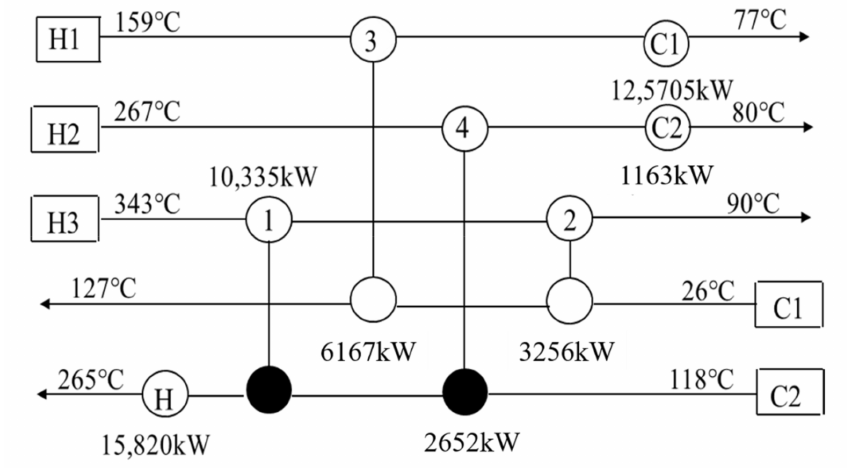
Figure 8. Pinched heat exchanger for case study